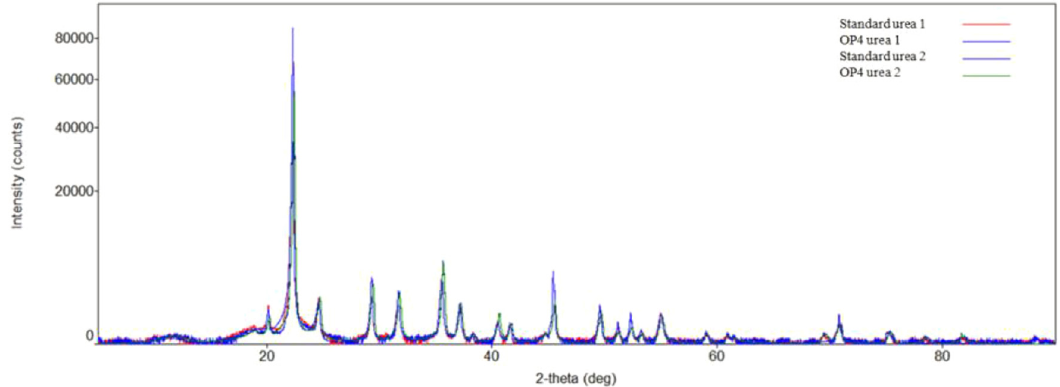
Fig. 21. Spectrum comparison of deposits and urea crystal.